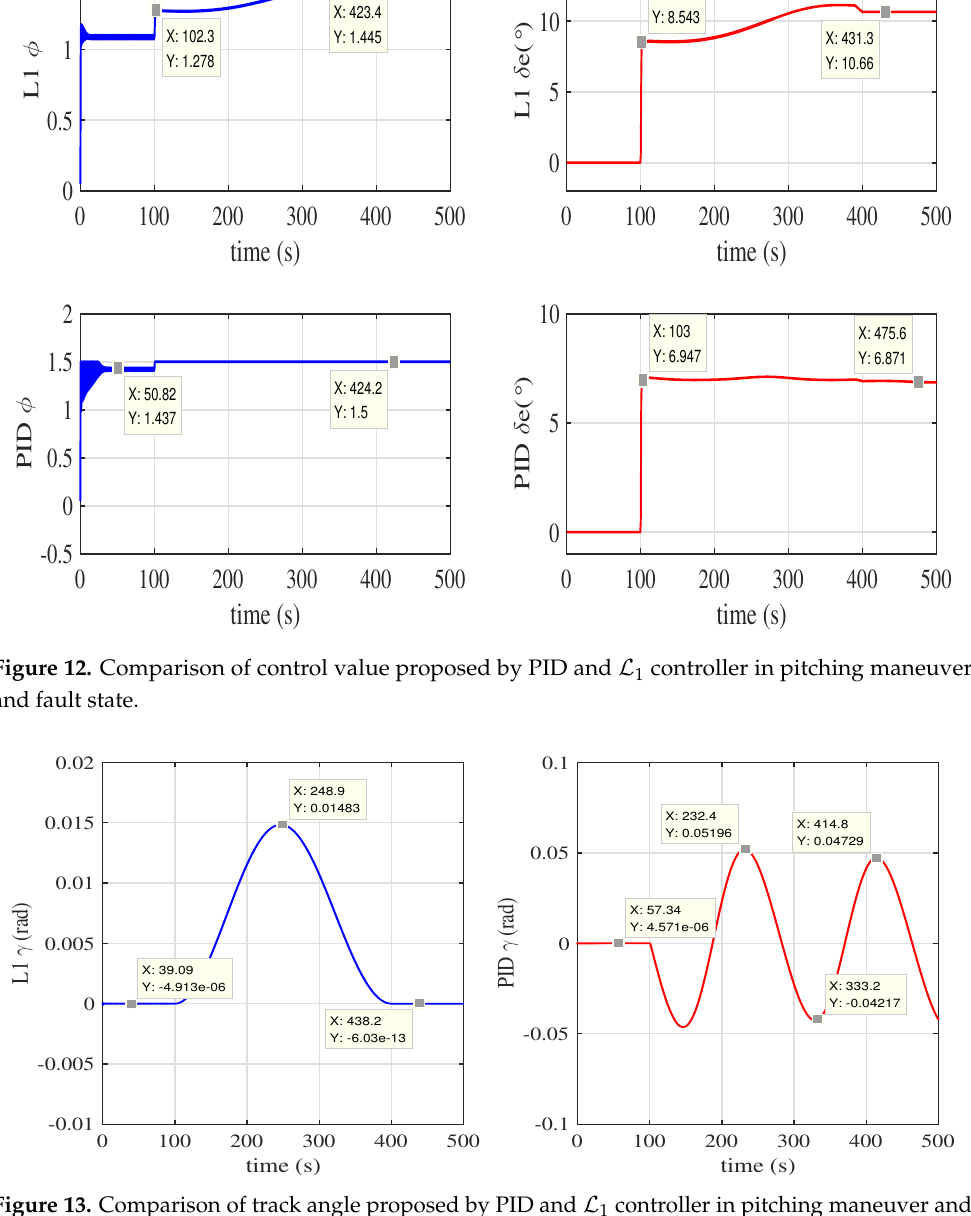
Figure 13. Comparison of track angle proposed by PID and L 1 controller in pitching maneuver and fault